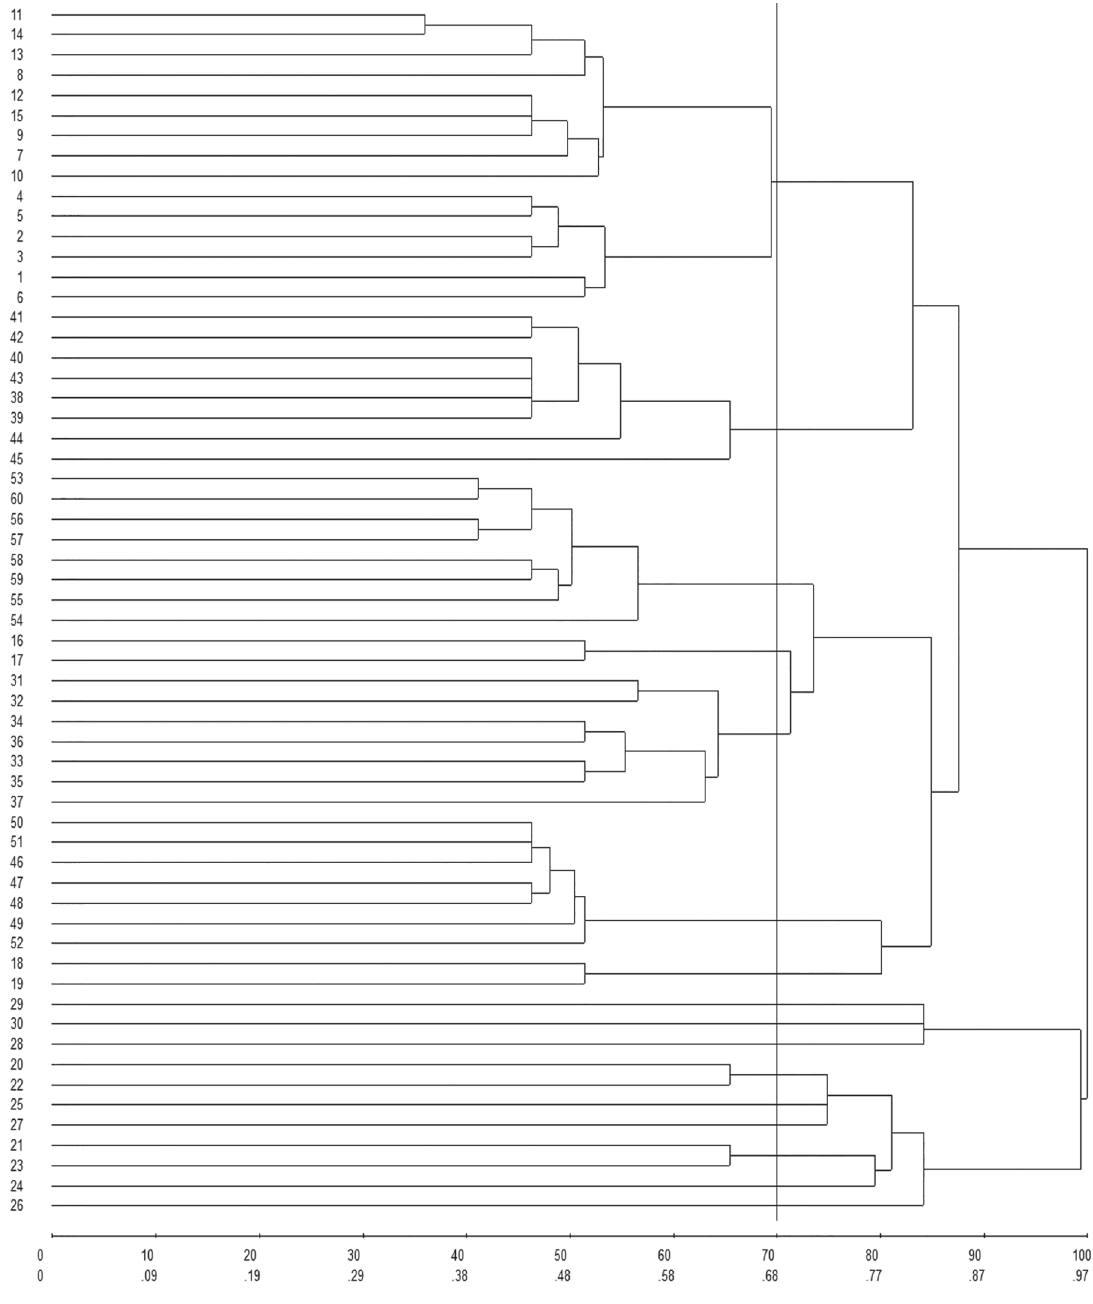
Figure 3 - Dendrogram obtained by cluster analysis using the mean Euclidean distance and the UPGMA method, for measuring the output of the first collection of honey. Set of 20 variables in 60 honey samples of A. mellifera in the counties of Marechal Cândido Rondon and Santa